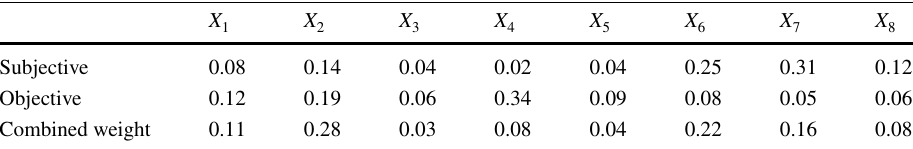
Fig. 3 The certainty degree of water resources carrying capac- ity evaluation grade in Henan